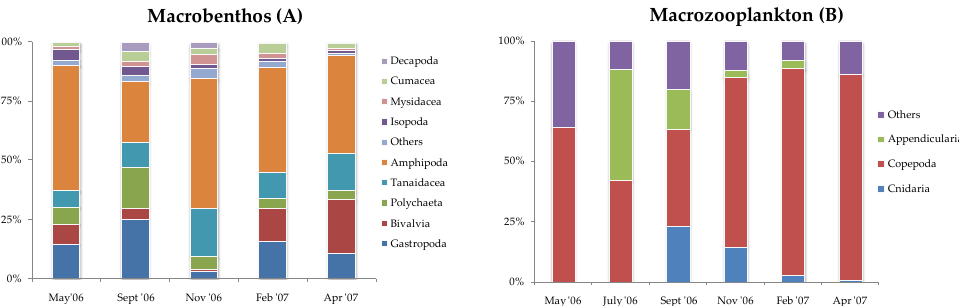
Figure 3. Relative abundance (% N) of the most important macrobenthic ( A ) and zooplanktonic ( B ) groups collected during the six sampling occasions in the study area.